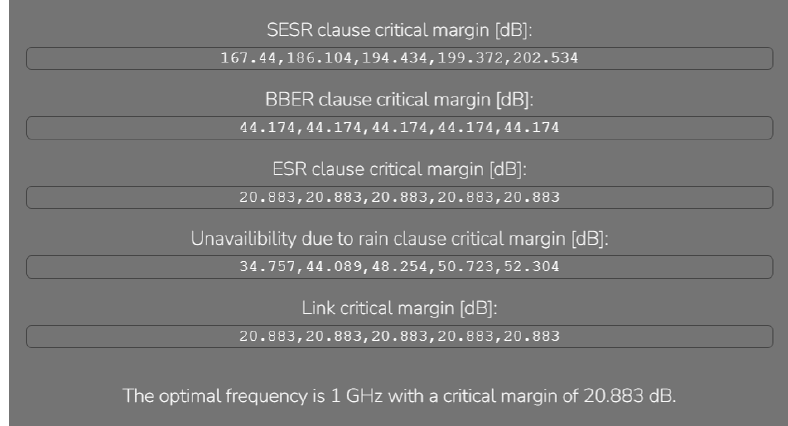
Figure 8. Critical margin window (2).